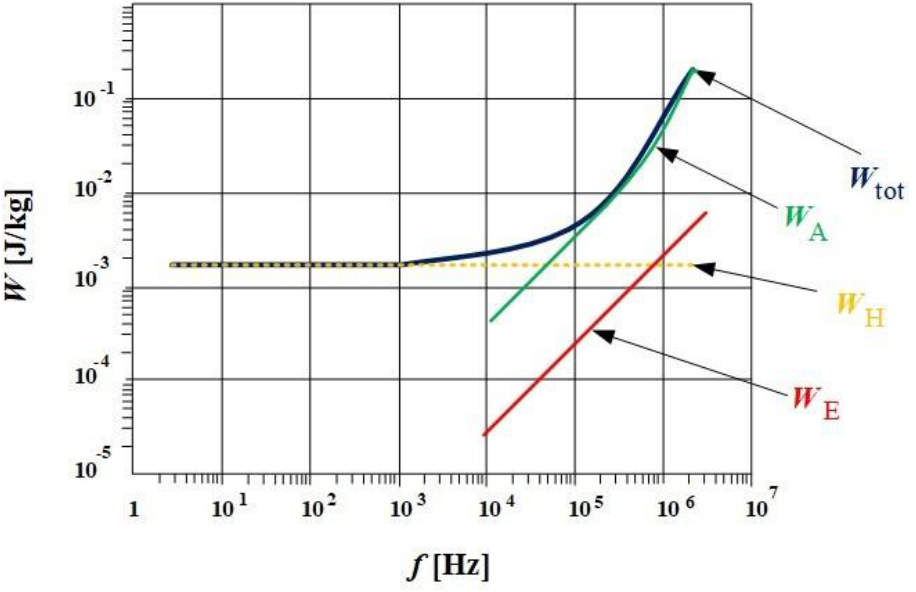
Figure 6. Exemplification of the procedure for separating energy losses for a certain value of the peak flux density.